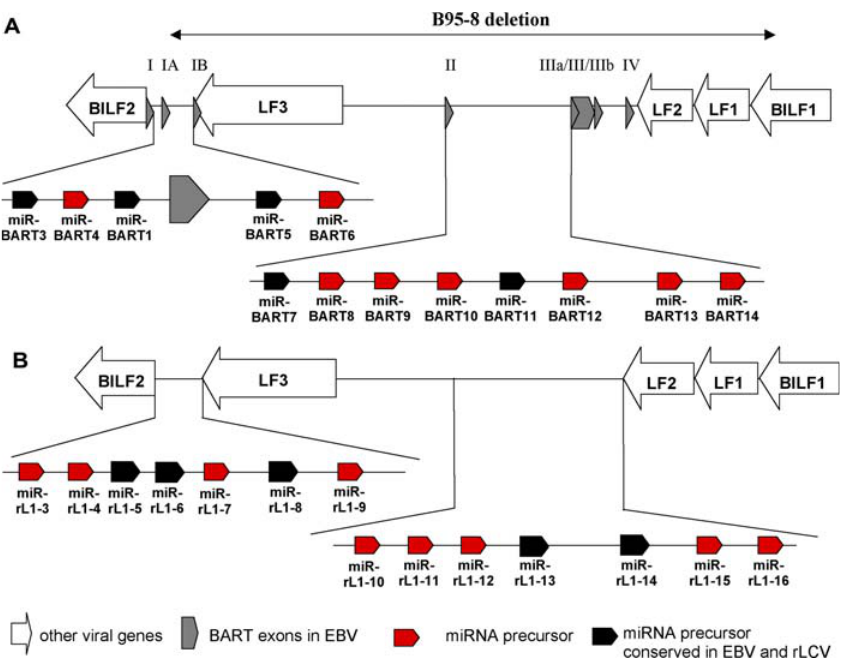
Figure 1. Genomic Location of Selected EBV and rLCV miRNAs (A) Schematic of a segment of the EBV genome, extending from 137,490 to 152,641, with EBV genes located on the antisense strand and BART mRNA exons located on the sense strand indicated. The location of the EBV BART miRNAs identified in this report is indicated. Also shown is the extent of the BART gene deletion found in the EBV B95–8 strain. Not shown are the three miRNAs encoded within the EBV BHRF1 miRNA cluster, which extends from 41,474 to 42,990, or the miR-BART2 miRNA, which is located 3 9 to the other BART miRNAs between positions 152,747 and 152,768. (B) Schematic of a similar segment of the rLCV genome, extending from position 131,487 to 148,684, with known rLCV homologs of EBV genes indicated. The rLCV miRNAs identified in this report are indicated and the miRNAs conserved in EBV highlighted. Although the BART gene is thought to be conserved in this region of the rLCV genome, based on sequence analysis, the BART exons in rLCV have not been mapped. Not shown are the rLCV miR-rL1-1 and miR-rL1-2 miRNAs, which are encoded 3 9 to position 35,323 and 36,709,